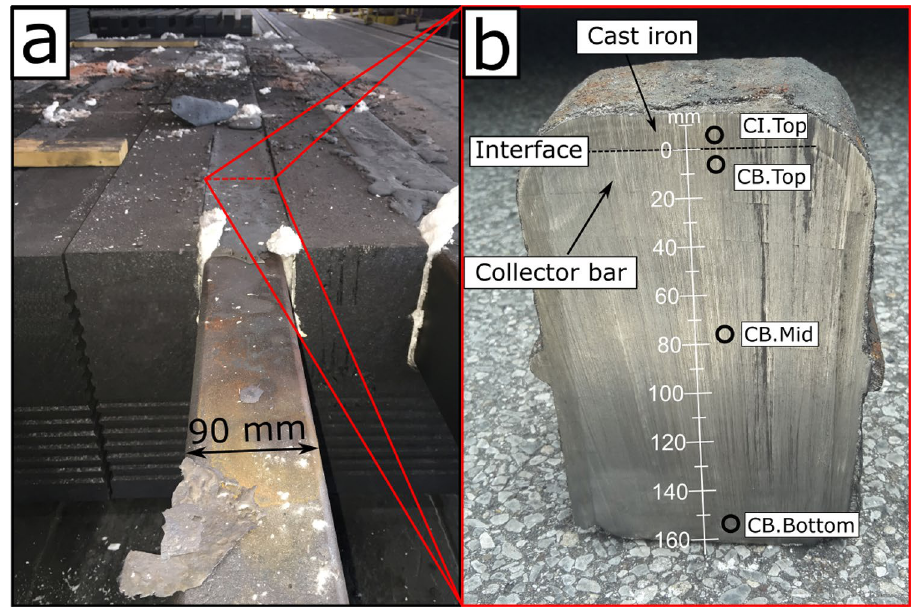
Fig. 2 Material compound of graphite and collector bar with cast iron as the connecting material ( a ). The cathode block is flipped upside down in the electrolysis cell. Cross section of the collector bar after usage in a cell ( b ). At the marked positions (circles), samples have been taken for investiga- tion and labelled according to material and